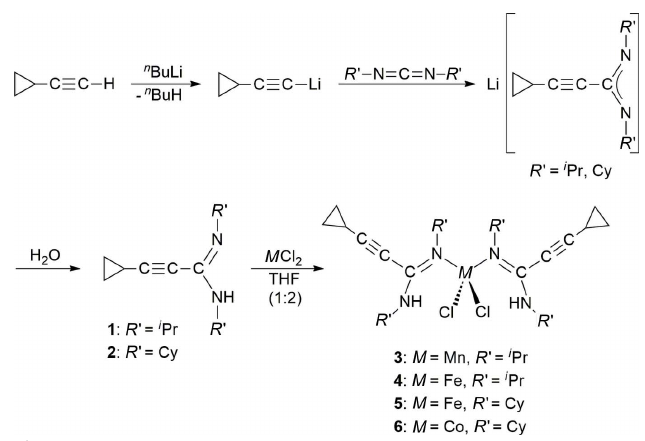
Figure 1 Bottom-up synthesis of the title compounds 3 – 6 starting from cyclo-